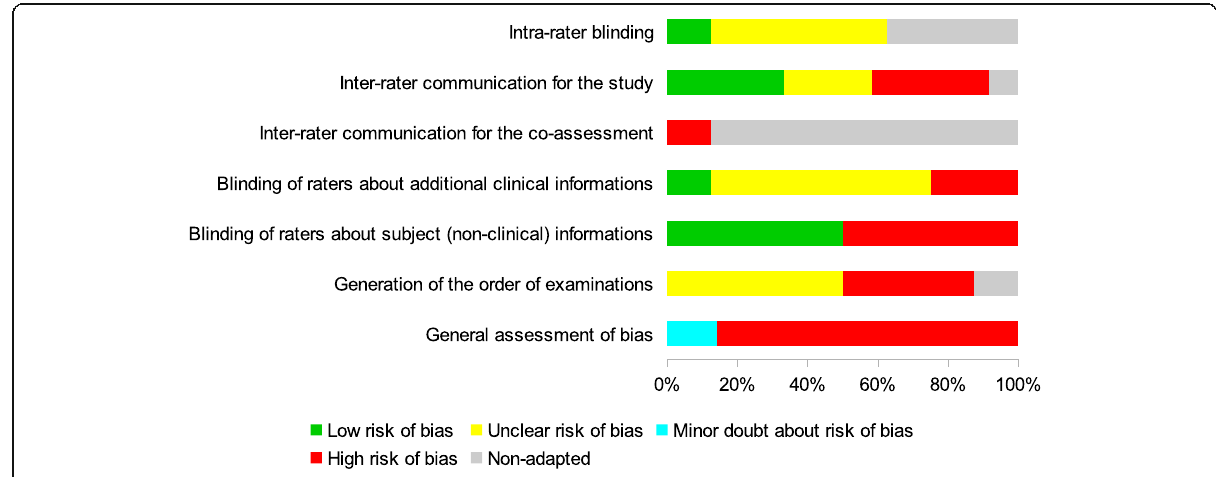
Fig. 3 Assessment of methodological risk of bias for the reliability studies taken together. Green shading indicates a low risk of bias, yellow an unclear risk of bias and red a high risk. Grey shading color indicates non-applicable items. For general assessment of bias, purple shading and cyan shading indicates a major doubt and a minor doubt as to the overall risk of bias,